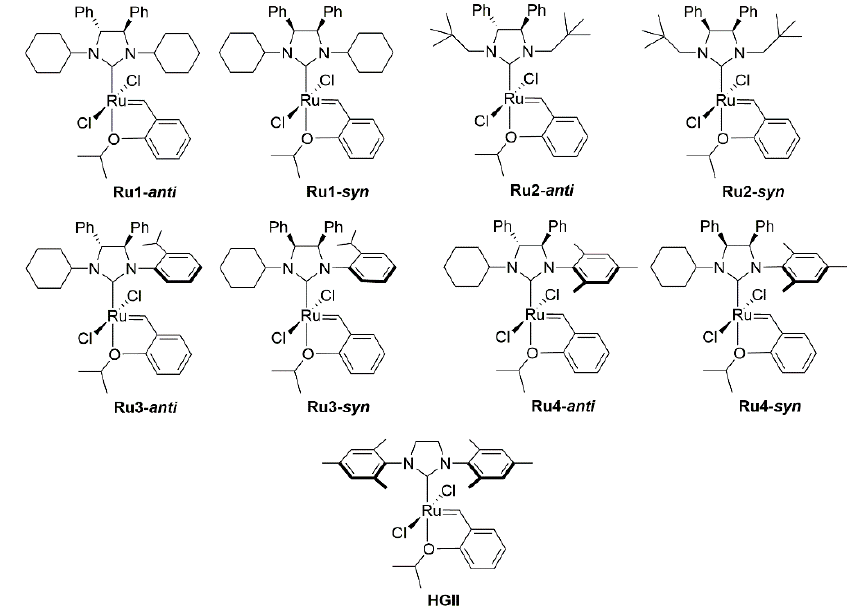
Figure 1. The Hoveyda–Grubbs second generation catalysts used.